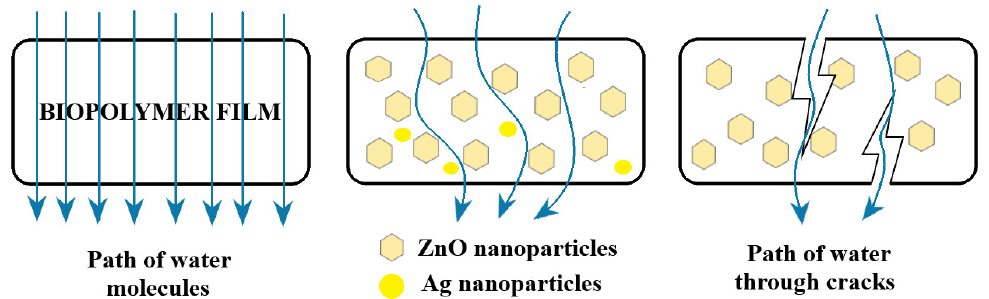
Figure 14. The water vapor permeability (WVP) mechanism for the control film ( left ), chitosan– ZnO&AgNPs films ( middle ), and cracked films ( right ). Table 6. Water vapor permeability (WVP) for control, CZ, CA, and CZA films.